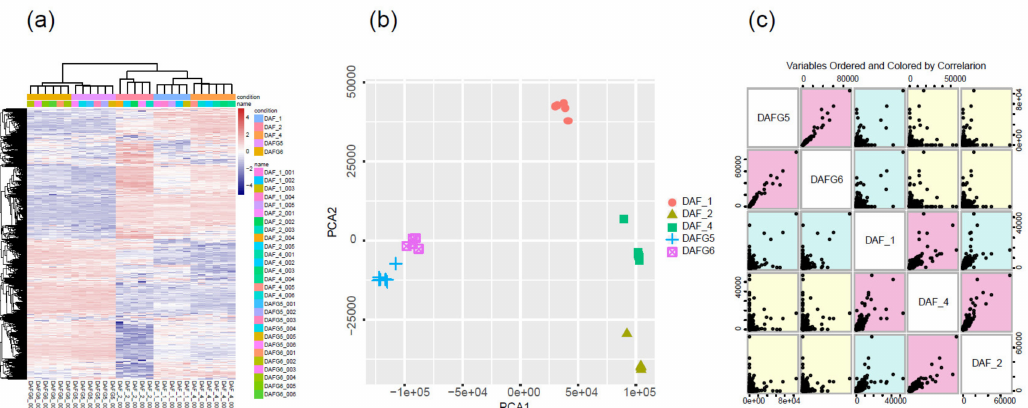
Figure 2. Schematic illustration of global gene expression profiles and sample reproducibility of three di ff erent gluteus tissue resources (abnormal fetus and normal fetuses at 100 gestational days, postnatal lambs) and two cell types (transgenic-silencing and -expressing cells). ( a ) Heatmap comparing global transcriptome profiles of di ff erent samples; the pink color represents a higher expression level, and the blue color represents a lower expression level. ( b ) PCA illustrated the reproducibility and rationality of sample collection. ( c ) Variable order of sample pairs colored by